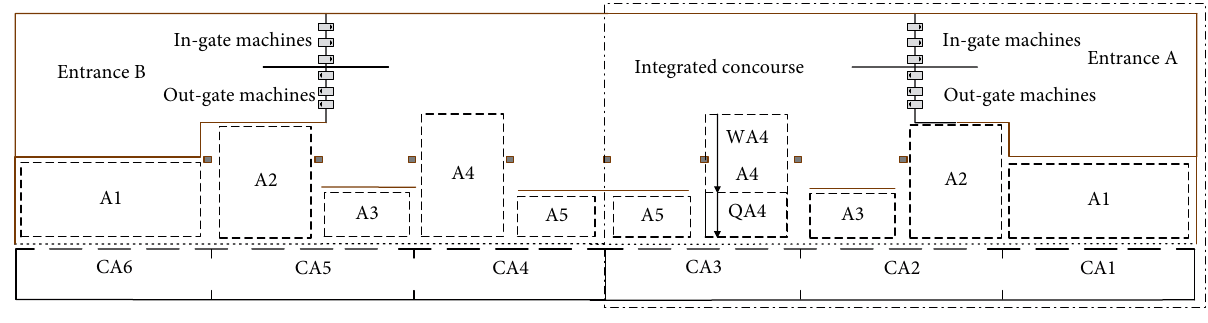
Figure 9: Area division of UP_L13. Either part of UP_L13 can be divided into five subareas referred to as A1–A5. For the process of waiting- boarding trains, each sub-area consists of the queuing area and walking area marked as QA and WA respectively, as illustrated by A4 including WA4 and QA4. A representative of a path along the UP_L13 is shown in solid black arrows.